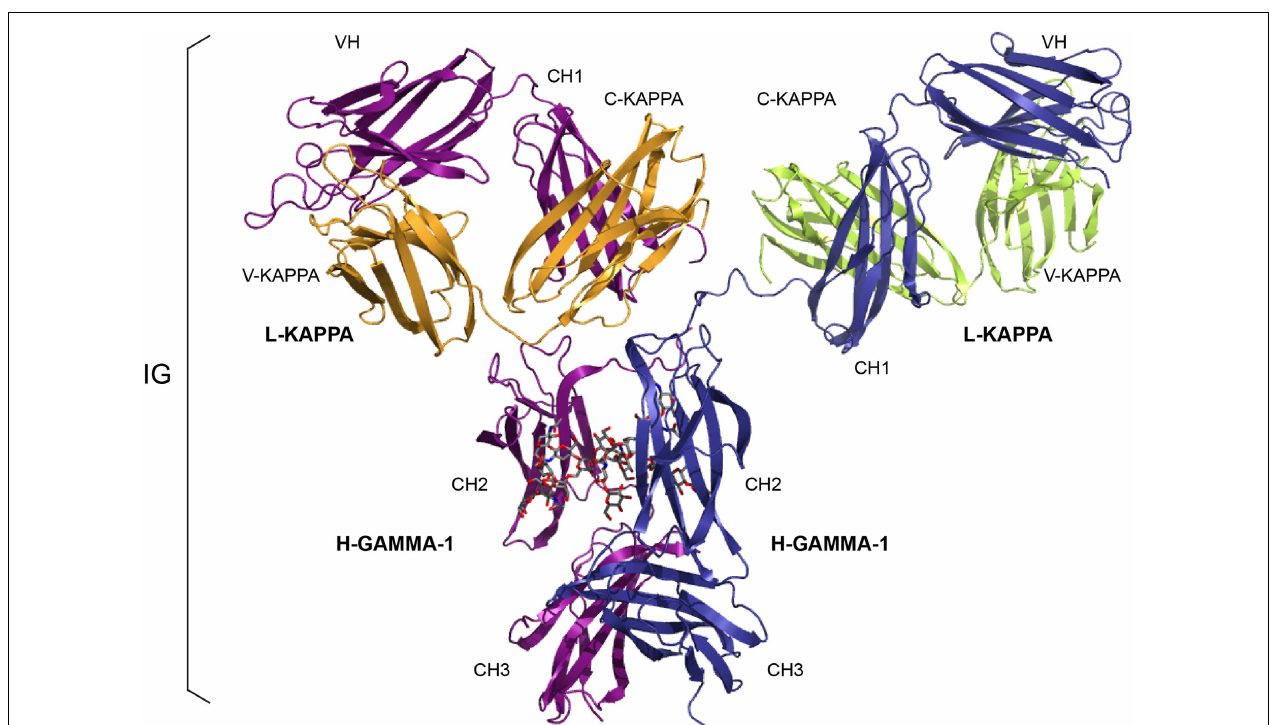
The light chain (here, L-KAPPA) is made of a variable domain (V-DOMAIN, here,V-KAPPA) at the N-terminal end and a constant domain (C-DOMAIN, here, C-KAPPA) at the C-terminal end.The heavy chain (here, H-GAMMA-1) is made of aVH (at the N-terminal end) and of three CH (four for H-MU or H-EPSILON) ( Table 1 ) (2).The structure is that of the antibody b12, an IgG1-kappa, and so far the only complete human IG crystallized [1hzh from IMGT/3Dstructure-DB